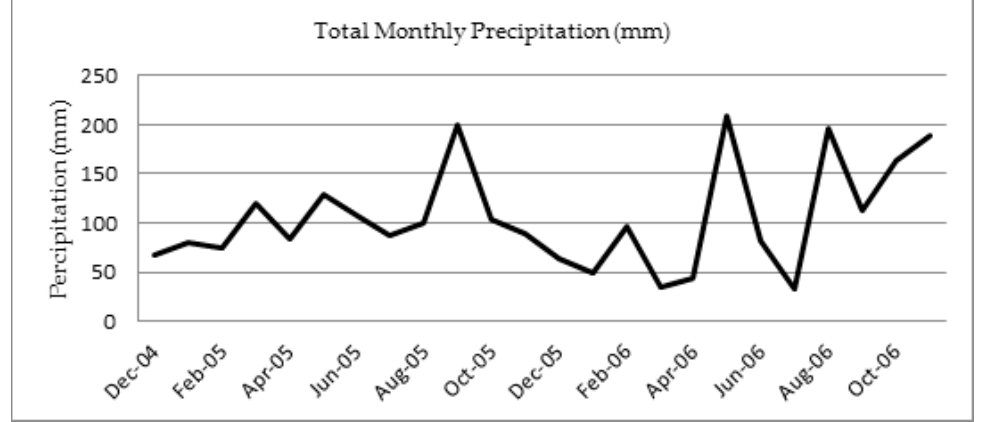
Figure 3. Fredericton, New Brunswick region total precipitation over one year.